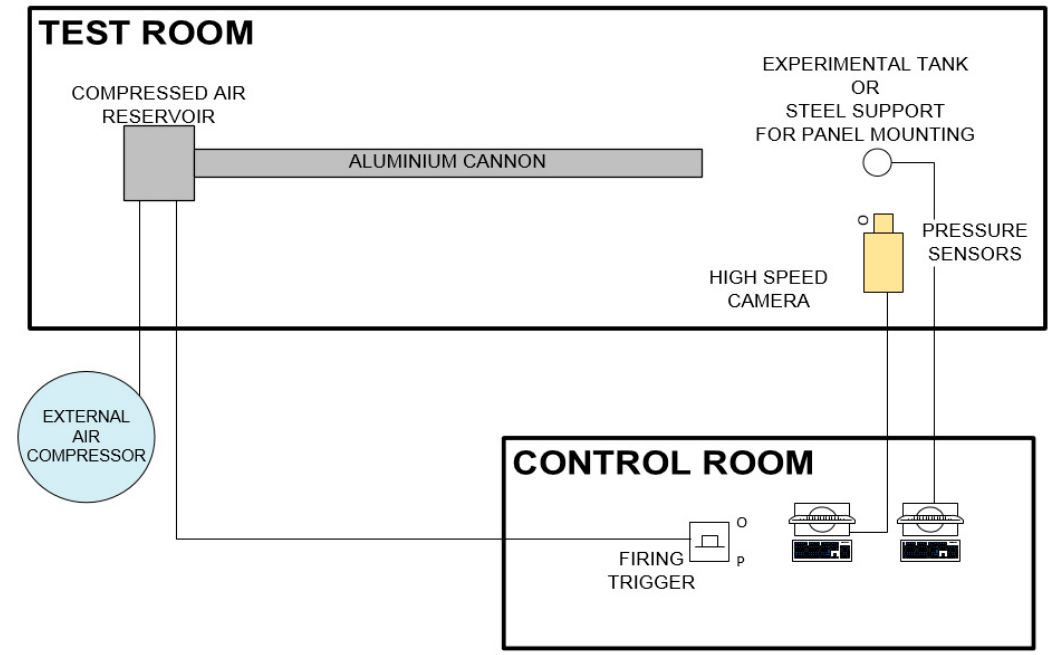
Figure 2. Schematic of the ballistic test system.